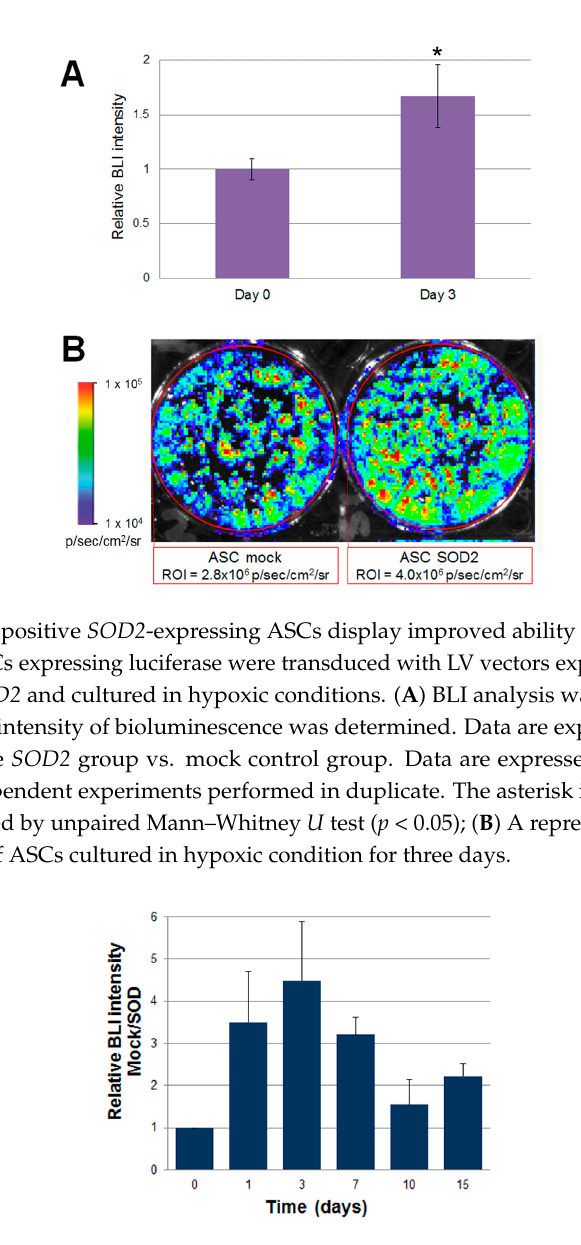
Figure 4. SOD2 -expressing ASCs show improved engraftment potential in vivo. Adipose tissue-derived stromal and vascular cells (ASCs) expressing luciferase after lentiviral-mediated gene transfer of either GFP (mock) or superoxide dismutase ( SOD2 ) cells were injected subcutaneously (7 × 10 5 cells/mouse) into a Matrigel plug into syngeneic mice ( n = 6 per group). At different time points, bioluminescence imaging analysis (BLI) was performed and quantified. Data are expressed as the ratio of the BLI signal of the SOD2 group vs. mock control group. Difference of BLI signals between control (GFP) and SOD2 group was significant at all analyzed time points.